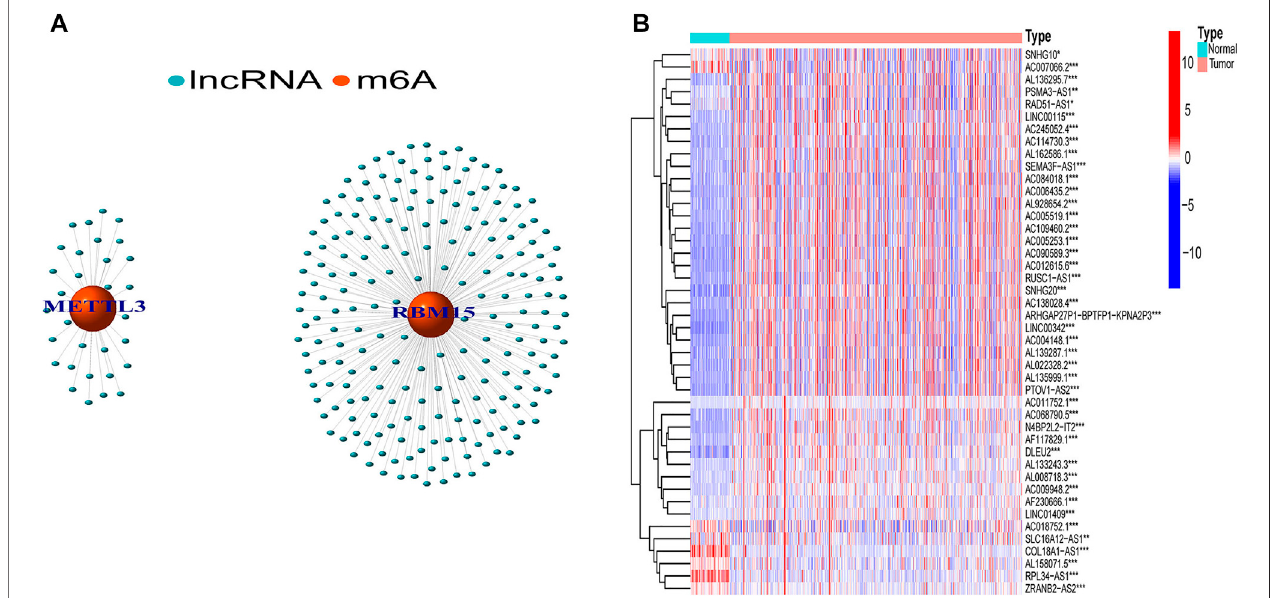
FIGURE 1 | Screening of hub lncRNAs. (A) Network of the 23 selected m6A-related genes and their associated lncRNAs. (B) Differential expression of the 44 prognostic m6A-RLs in tumor and normal samples. * p < 0.05, ** p < 0.01, *** p < 0.001.